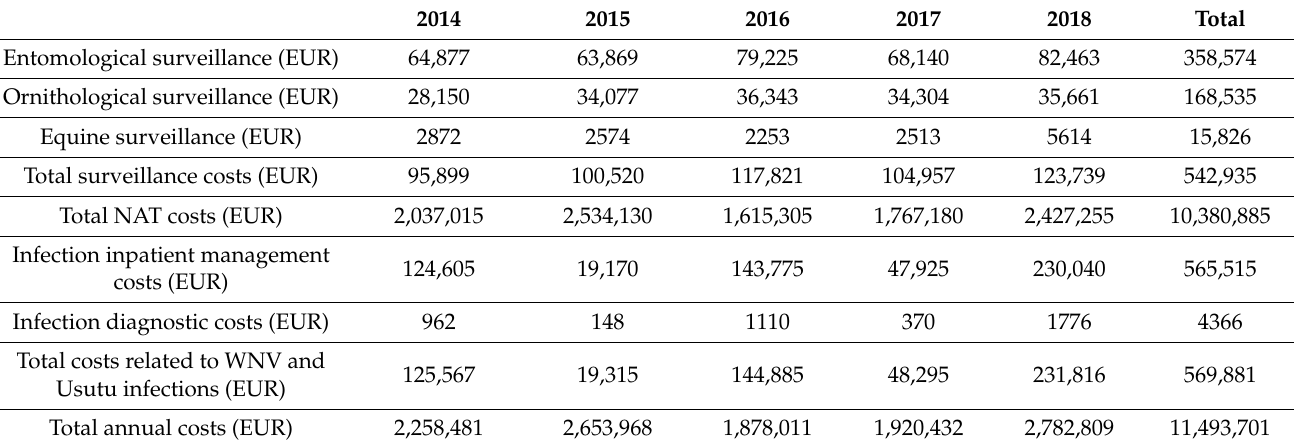
Table 6. Costs related to surveillance activity, NATs, and human infection